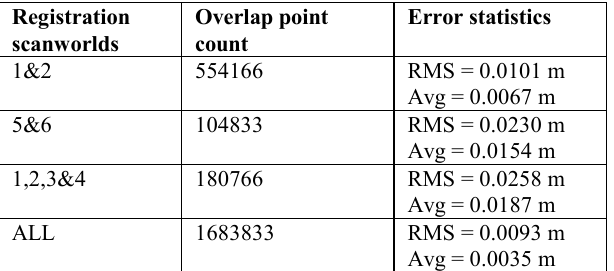
Table 2 Example error statistics; RMS (root mean square), Avg (average)